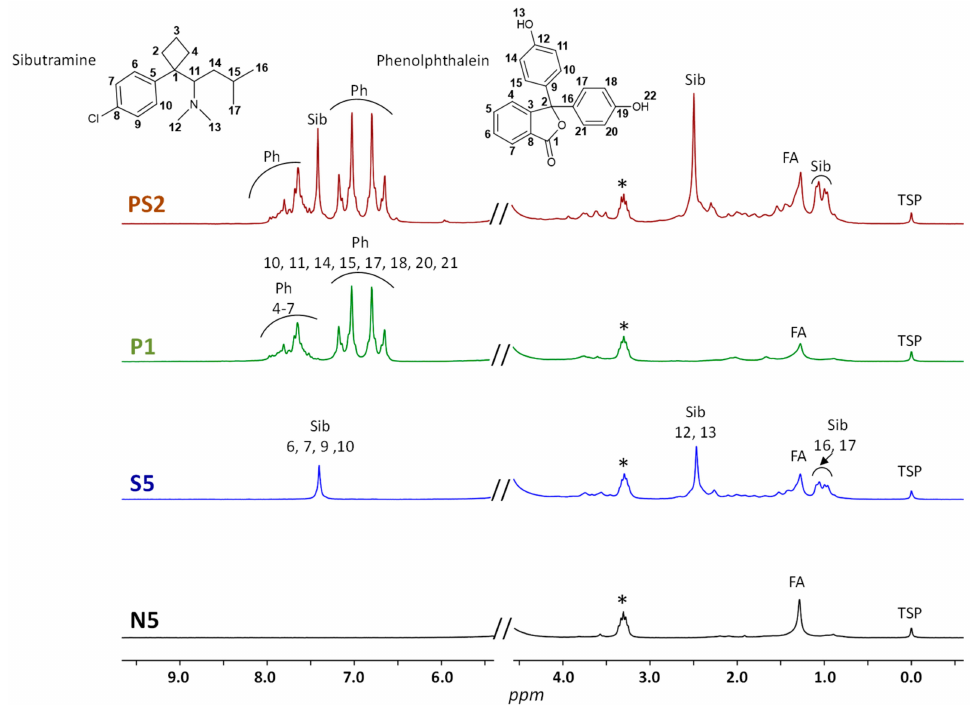
Figure 1. Typical LF 1 H NMR spectra of weight-loss dietary supplements recorded at 60 MHz (N, non-adulterated (natural) group; S, sibutramine-adulterated group; P, phenolphthalein-adulterated group; PS, both sibutramine and phenolphthalein-adulterated group). Ph: Phenolphthalein; Sib: Sibutramine; FA: Fatty acids; TSP: Internal reference; *: CD 2